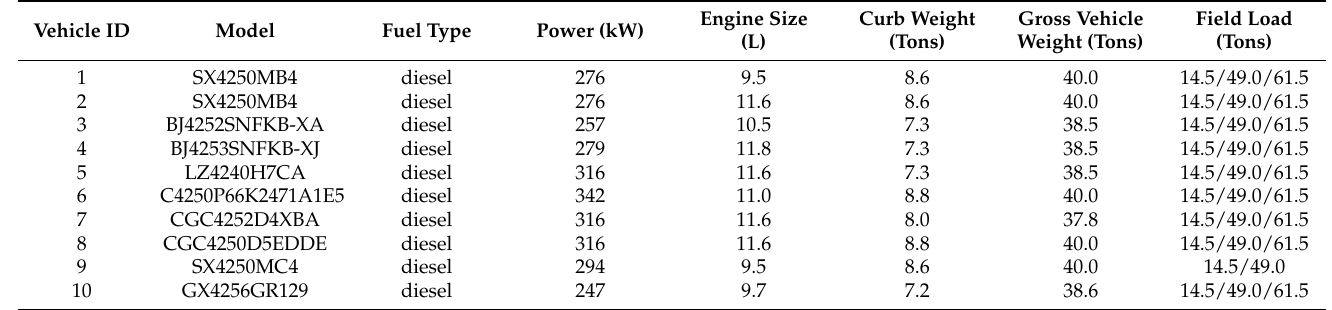
Table 1. Basic information about DSTTTs for speed data collection.